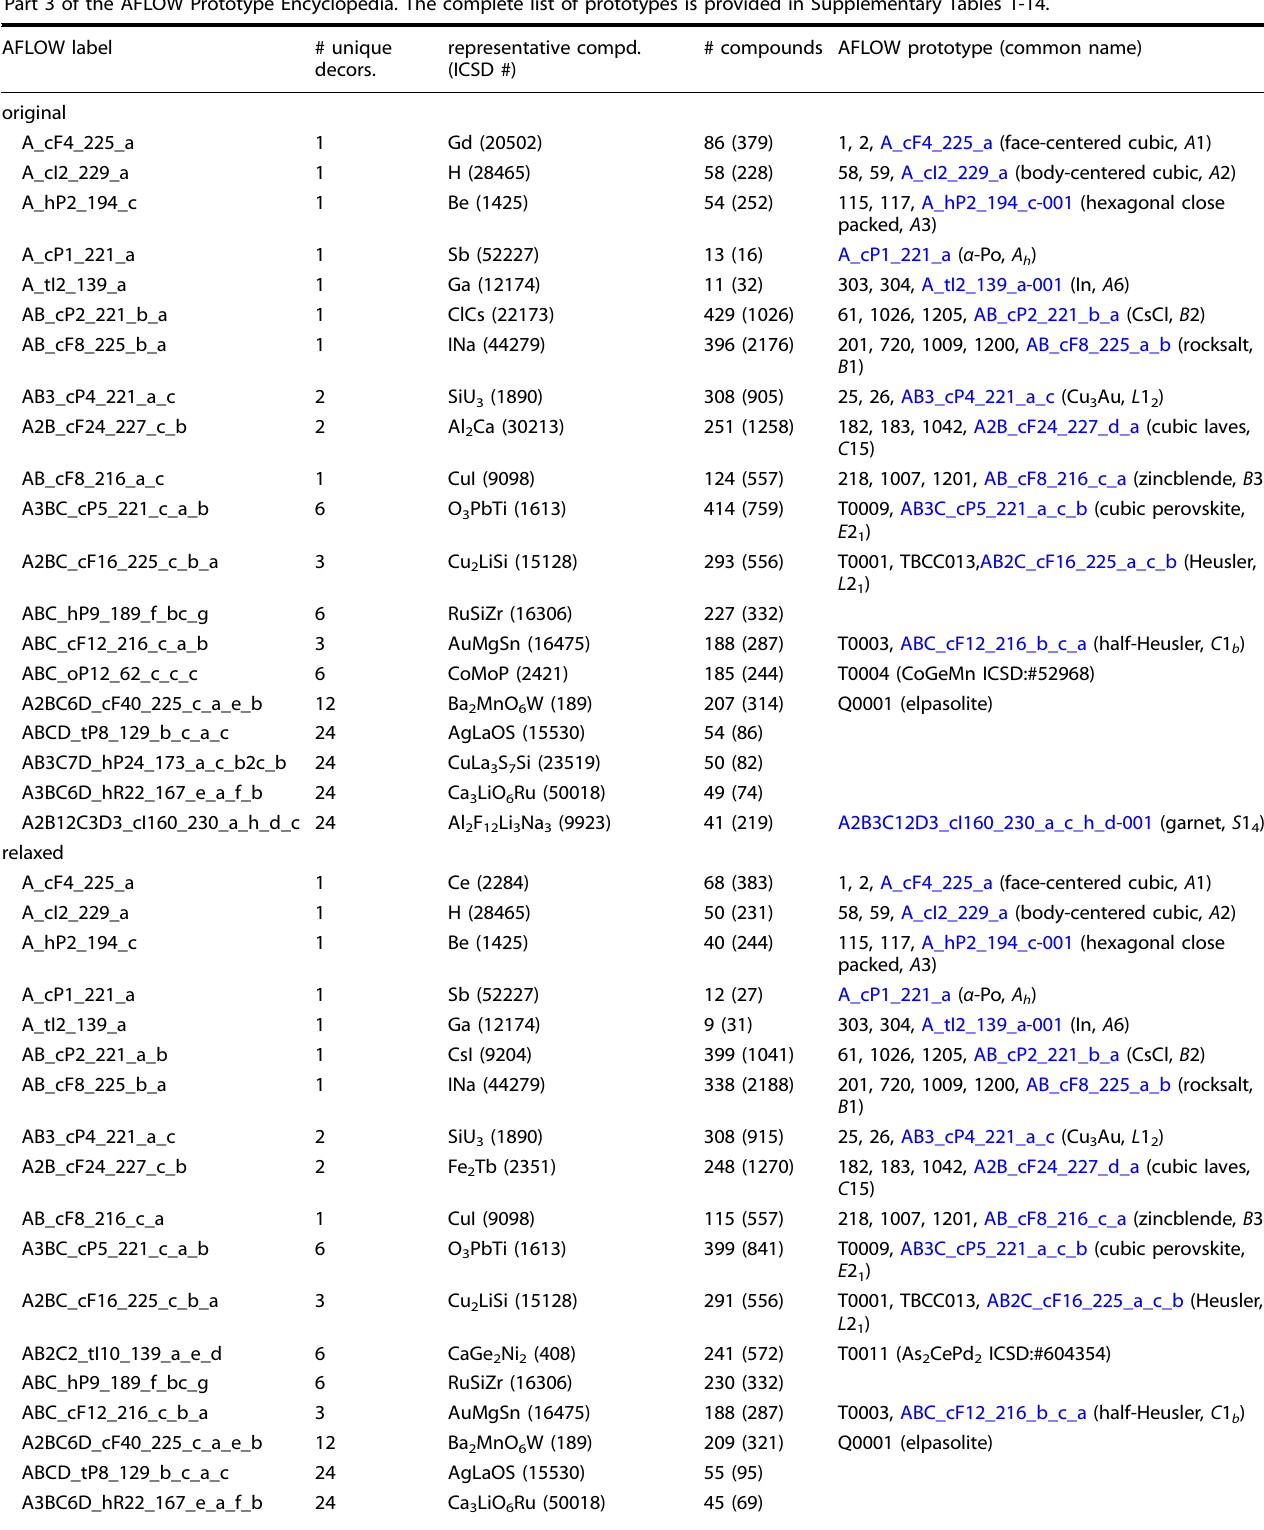
Table 5. Most frequent prototypes in the AFLOW-ICSD catalog. The fi ve most common prototypes are shown for unary, binary, ternary, and quaternary compounds as identi fi ed via XtalFinder. The original and relaxed geometry sets are shown on the top and bottom portions of the table, respectively. Each prototype is listed with the following information: AFLOW label, number of unique atom decorations, representative compound with its ICSD designation, number of unique compounds exhibiting the structure (along with the count when including duplicate compounds), and matches to existing AFLOW prototypes, if they exist. Empty rows in the AFLOW prototype column reveal new prototypes, which will be included in Part 3 of the AFLOW Prototype Encyclopedia. The complete list of prototypes is provided in Supplementary Tables